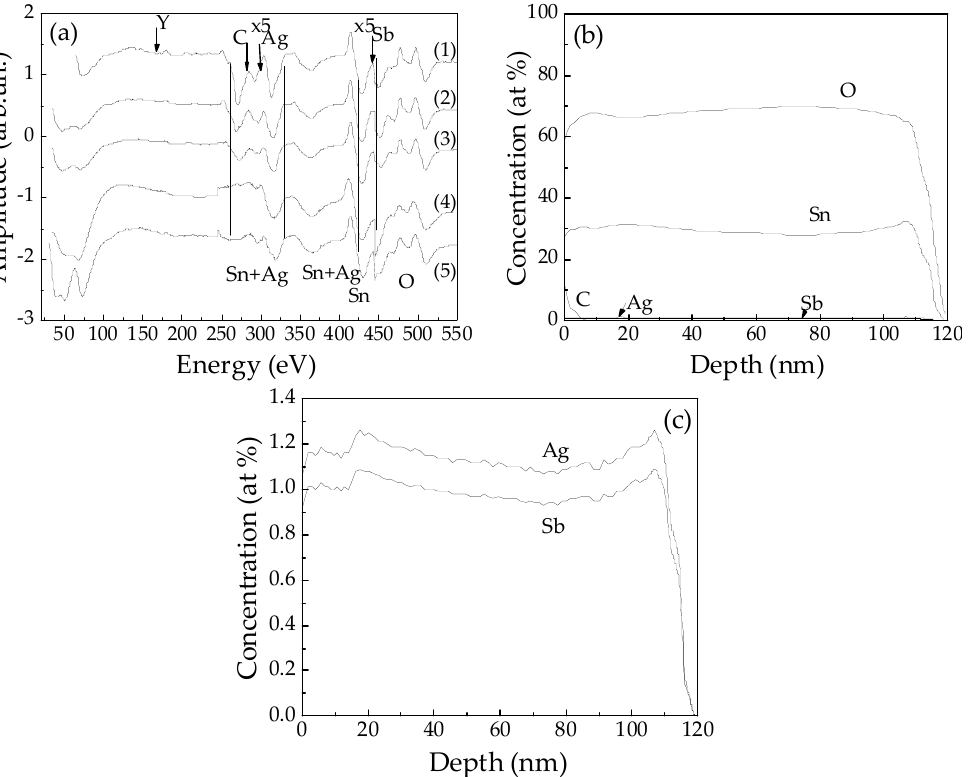
Figure 6. ( a ) Auger spectra of the SnO 2 :Sb, Ag, Y film with respect to electron kinetic energy in the near-surface region (1) and for the different layer depth, nm: 3 (2), 5 (3), 30 (4), and 90 (5). ( b ) In-depth profiles of all detected elements concentration ratio in SnO 2 :Sb, Ag, Y layer bulk and in-depth profiles of Ag and Sb concentration ( c ).